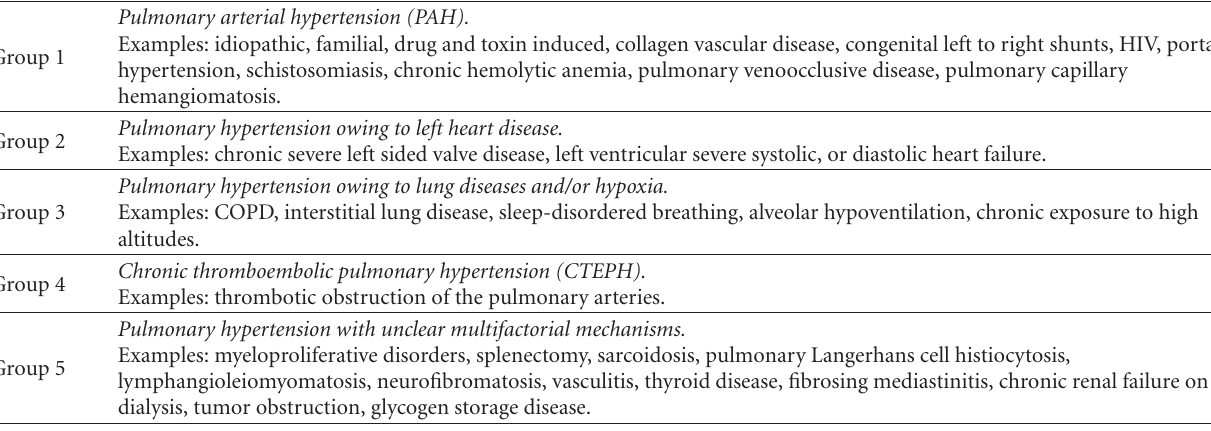
Table 1: Dana Point clinical classification of pulmonary hypertension